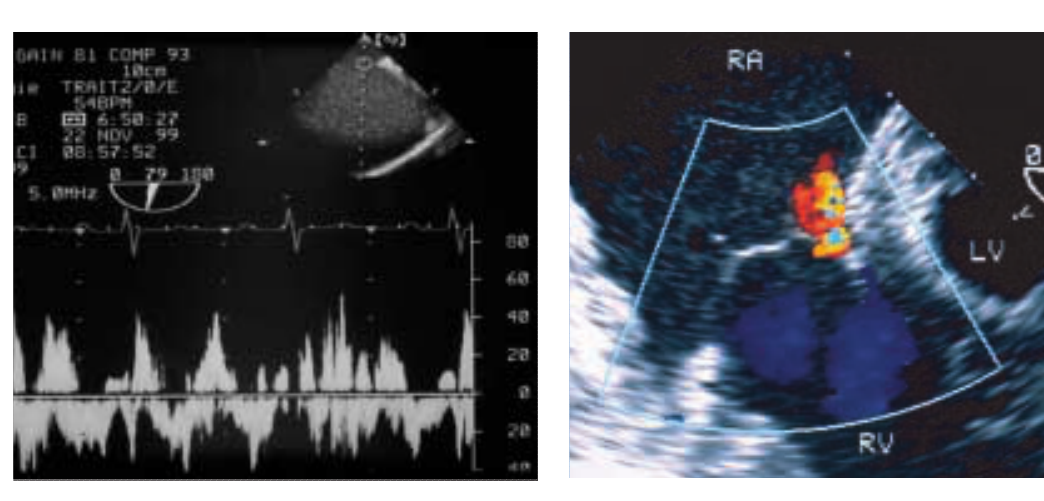
Pre-operative transoesophageal echocardiography, showing a very dilated right atrium.